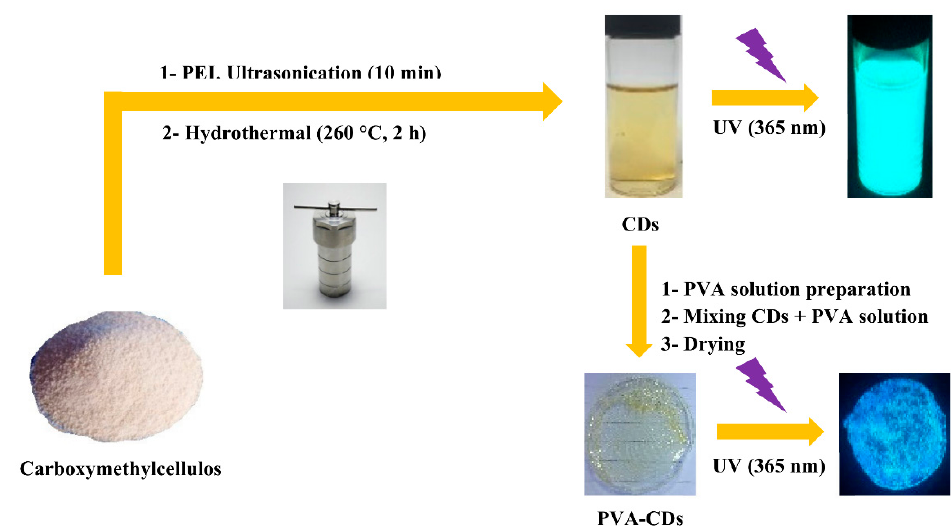
Figure 2. Illustration of preparation of CDs and PVA/CD film. Reprinted with permission from [102]. Copyright (2020) MDPI.